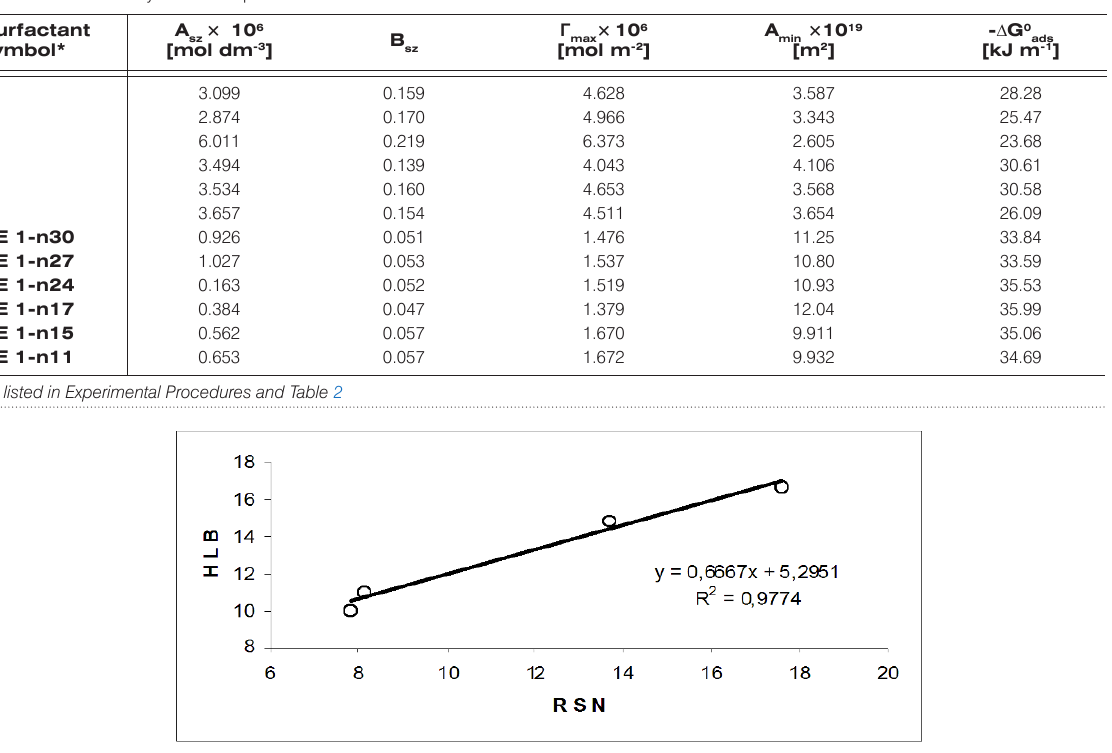
*as calculated from the synthesis weight balance Table 3.